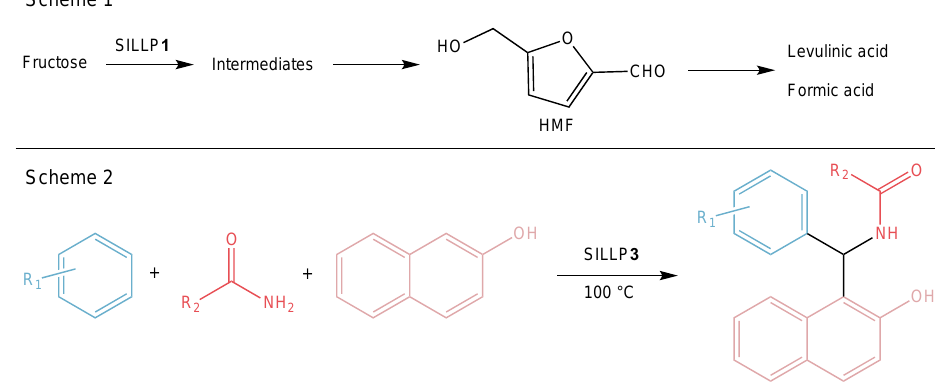
Figure 10. Brønsted-type SILLP based on silica material in the dehydration of fructose (Scheme 1) and synthesis of 1-amidoalkyl naphthols (Scheme 2).